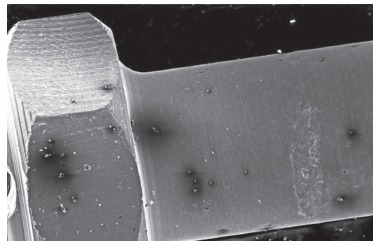
Photomicroscopy of SIN mini-implant after 30 days of immersion in artificial saliva (150x).